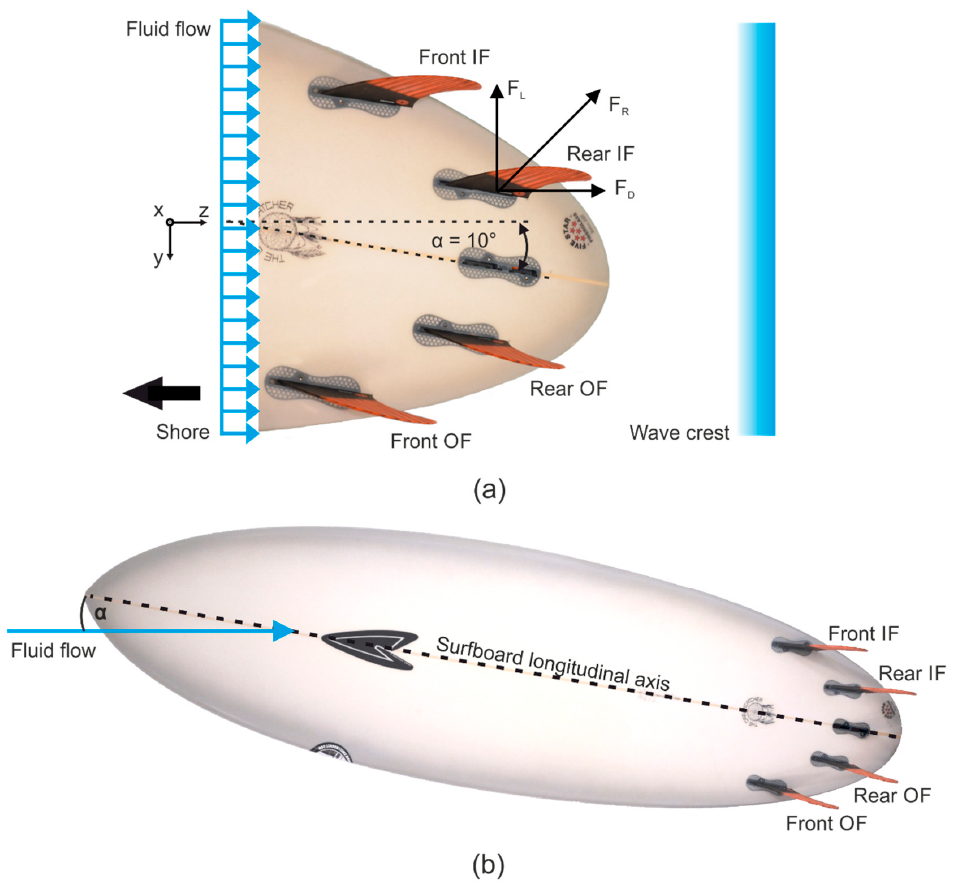
Figure 3. ( a ) Lift F L , drag F D , and resultant forces F R applying on the fins under an angle of attack (AoA) of α = 10 ◦ (bottom view, left-hand wave). ( b ) The surfboard, its longitudinal axis, and the fluid flow with an AoA of α = 10 ◦ (bottom view, left-hand wave).